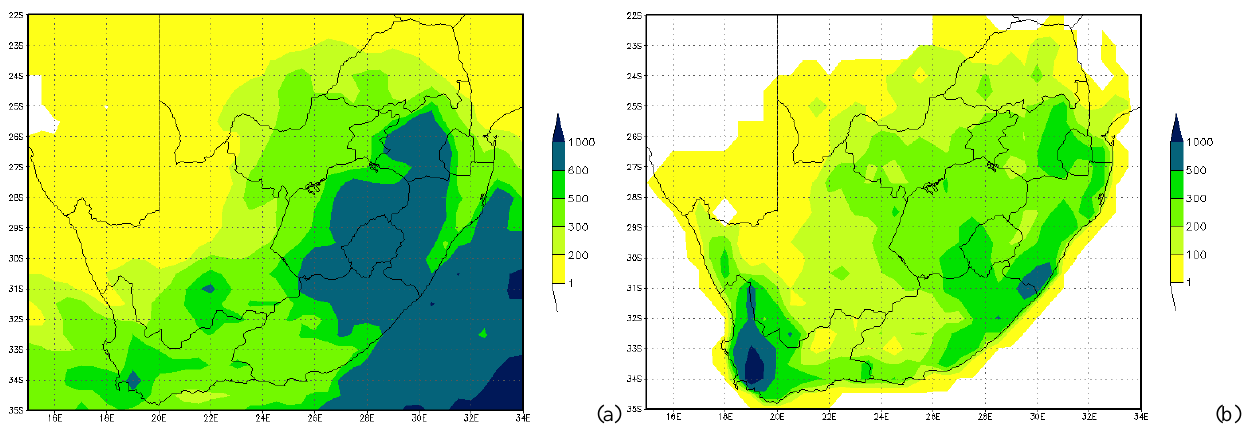
Fig. 5. HE winter rainfall for 2008 and 2009 (a) and rainfall measured by the gauges in the winters of 2008 and 2009 (b) .